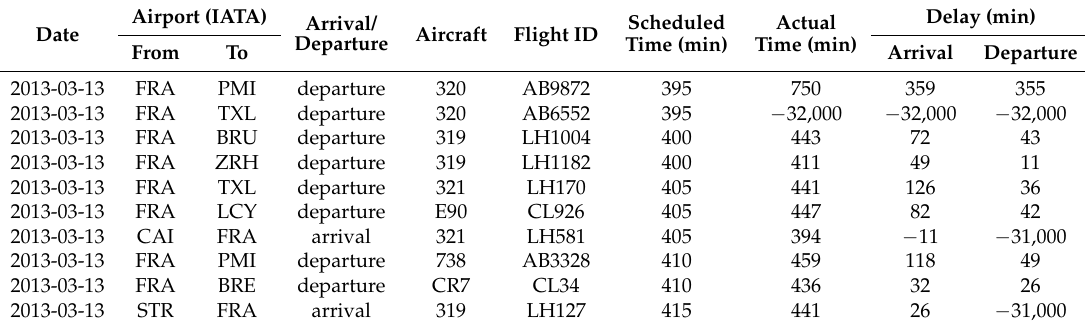
Table 1. Data set of airport related flights.